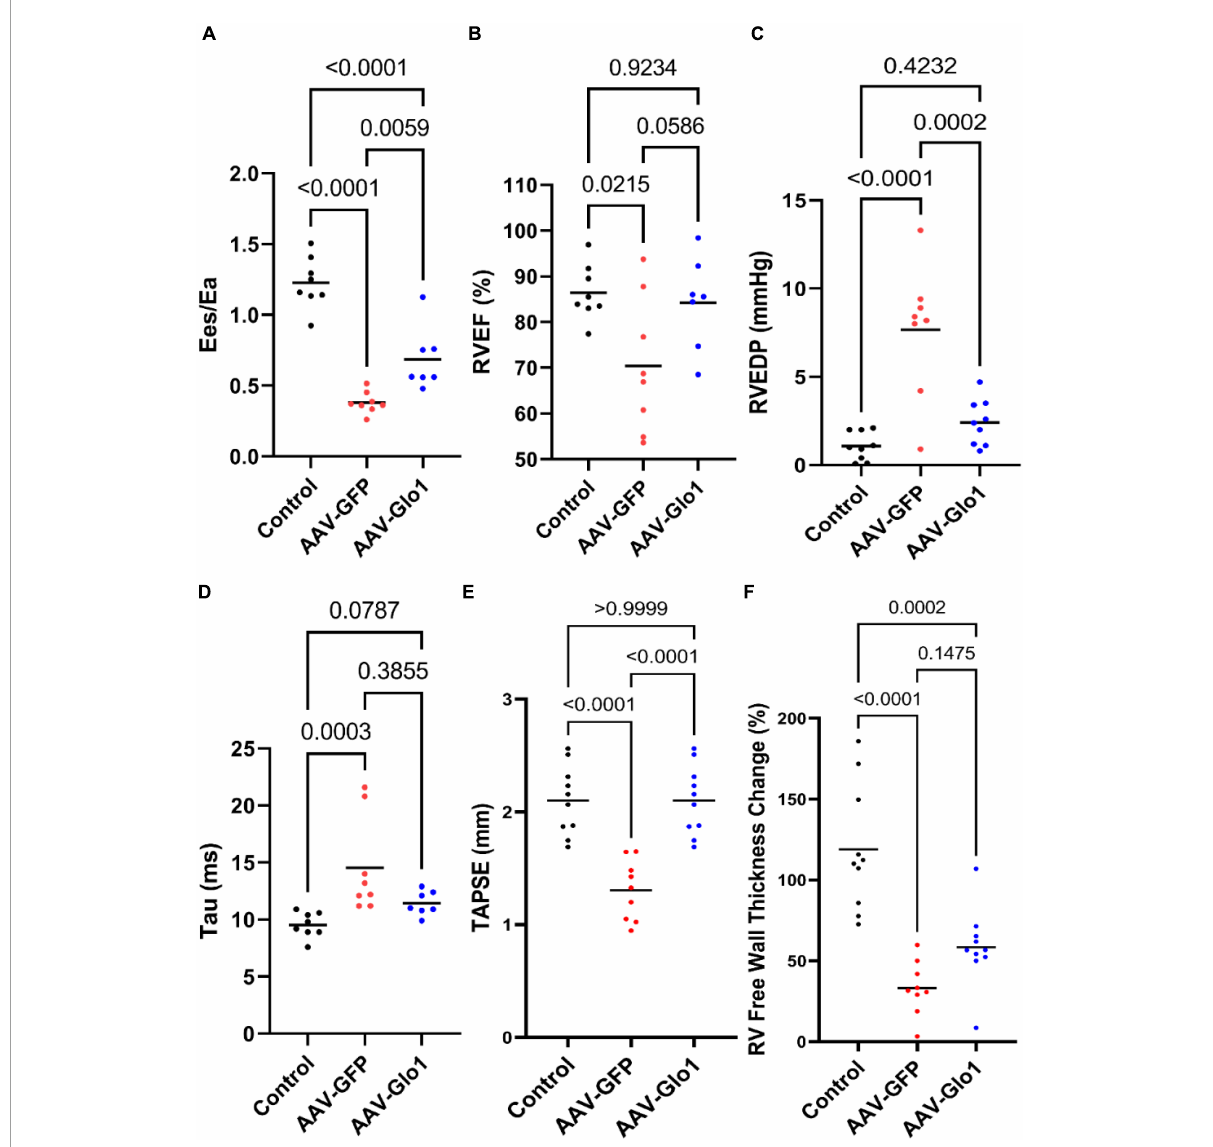
FIGURE6 GLO1 overexpression enhanced RV systolic and diastolic function. (A) AAV-Glo1 treatment significantly improved Ees/Ea. AAV-Glo1 non-significantly improved RV ejection fraction (RVEF) (B) and significantly reduced RVEDP (C) compared to AAV-GFP. (D) RV tau was non-significantly reduced by AAV-Glo1. (E) TAPSE was normalized by AAV-Glo1 treatment and (F) RV free wall thickening was augmented, although not statistically different from AAV-GFP animals. p -values determined by using one-way ANOVA with Tukey’s multiple comparisons test in (A–C,E,F) and Kruskal-Wallis test with Dunn’s multiple comparison test in (D)